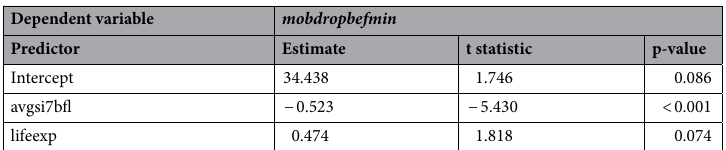
Table 2. Estimation results for a linear model of the mobility reduction achieved during a lockdown as a function of country characteristics. R 2 : 0.334, Adjusted R 2 : 0.313; F-statistic: 16.3 on 2 and 65 degrees of freedom (n =